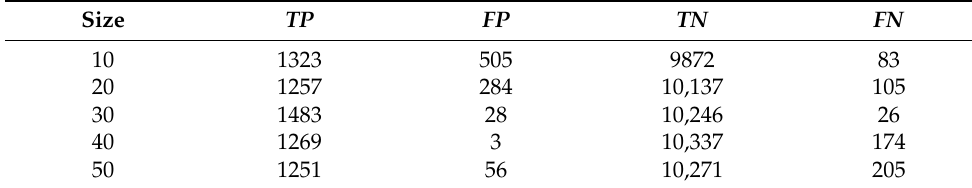
Table 5. Effect of size on TP , FP , TN , and FN .